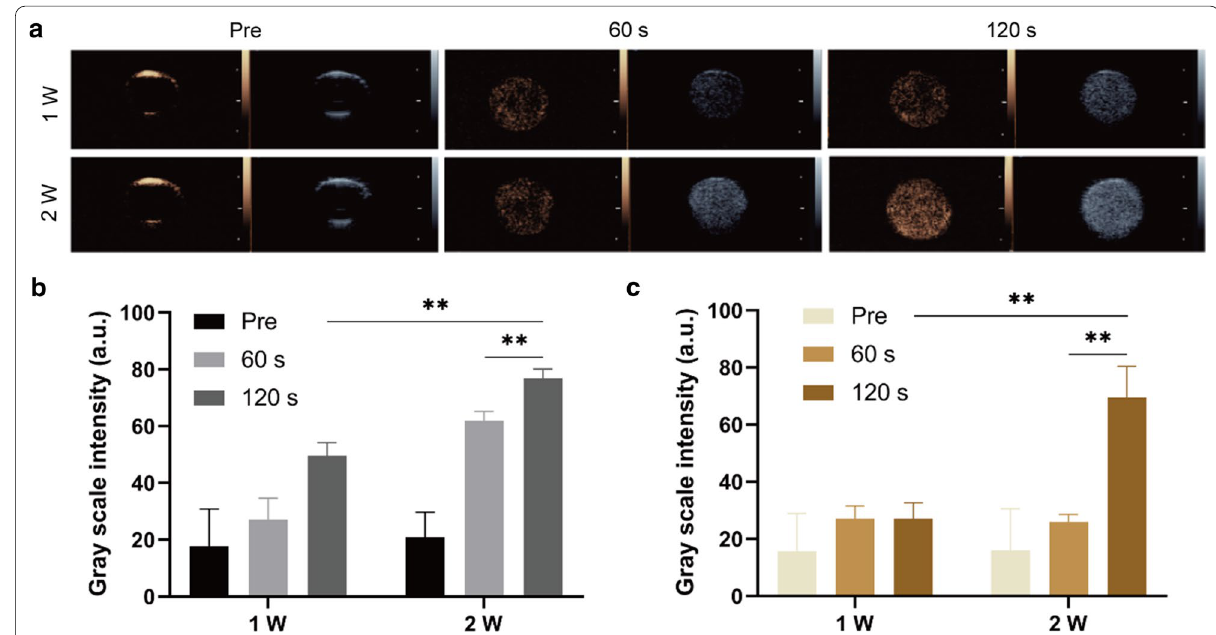
Fig. 2 a Ultrasound images of both 2D and CEUS under different LIFU intensities and duration times. b The corresponding grayscale intensity at different intensities and time of 2D imaging and c CEUS imaging (** p < 0.01, n